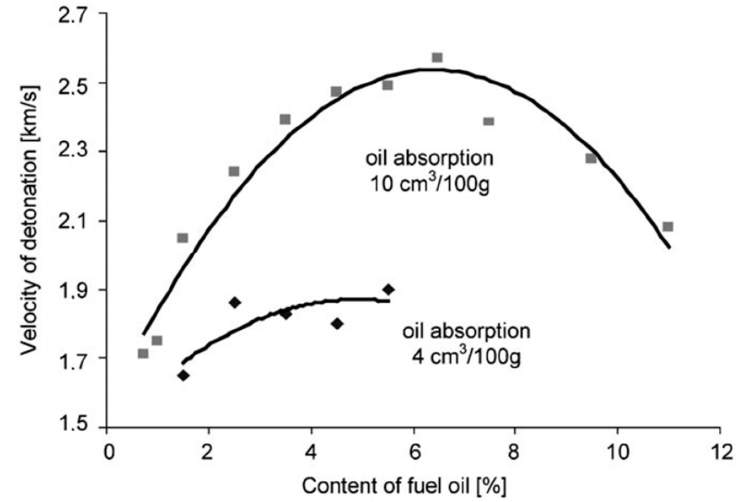
Figure 2. Detonation velocity of ANFO vs. content of fuel oil. Reprinted with the permission of John Wiley and Sons from [25]. Higher porosity increases the adsorption capacity of oils on the AN surface while reducing the density of the explosive [26,27] (Figure 3).